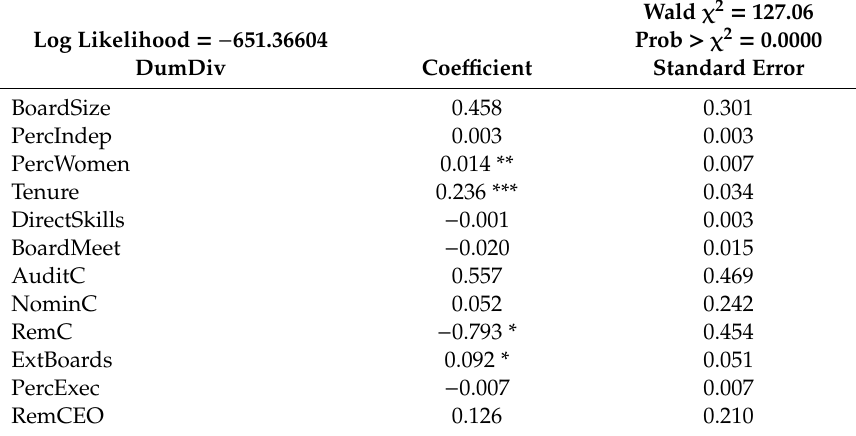
Table 2. Results of the regression based on a Probit model for all corporations. The independent variables are BoardSize, PercIndep, PercWomen, Tenure, DirectSkills, BoardMeet, AuditC, NominC, RemC, ExtBoards, PercExec, RemCEO, Dual, FormCEO, IndReel, FavTak, EqualVote, LShare, L5Share, C5Share, Leverage, GrowthOpp, EU, Euro, Crisis, Size, and Sector. The dependent variable is a